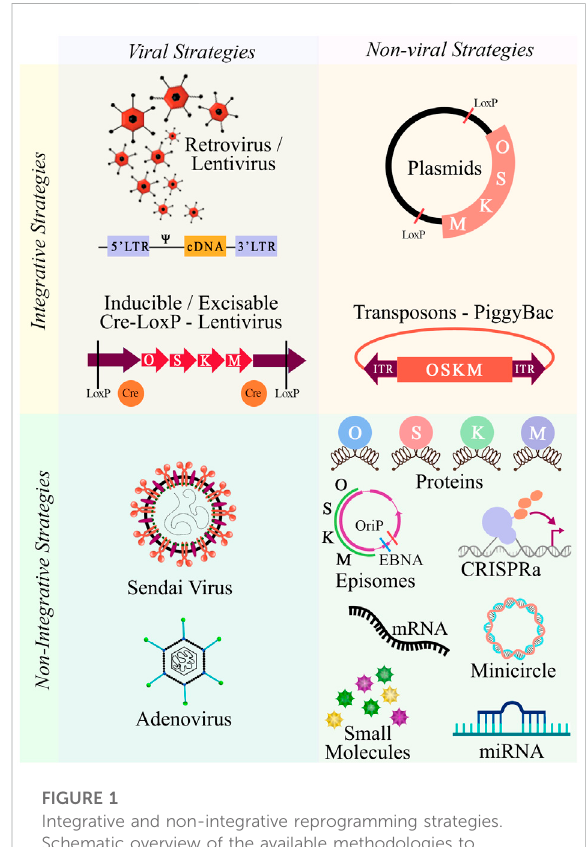
FIGURE 1 Integrative and non-integrative reprogramming strategies. Schematic overview of the available methodologies to dedifferentiate cells towards pluripotency. Abbreviations: O, OCT3/4; S, SOX2; K, KLF4; M,